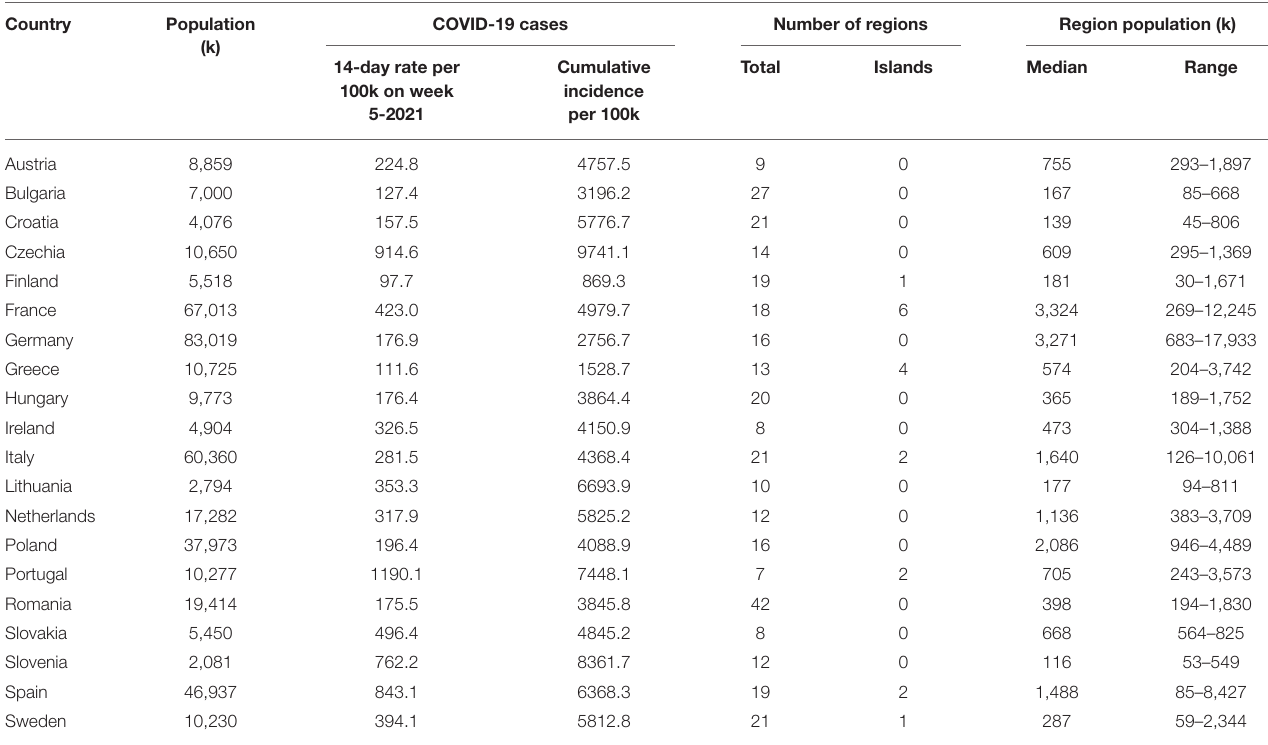
TABLE 1 | Description of countries included.